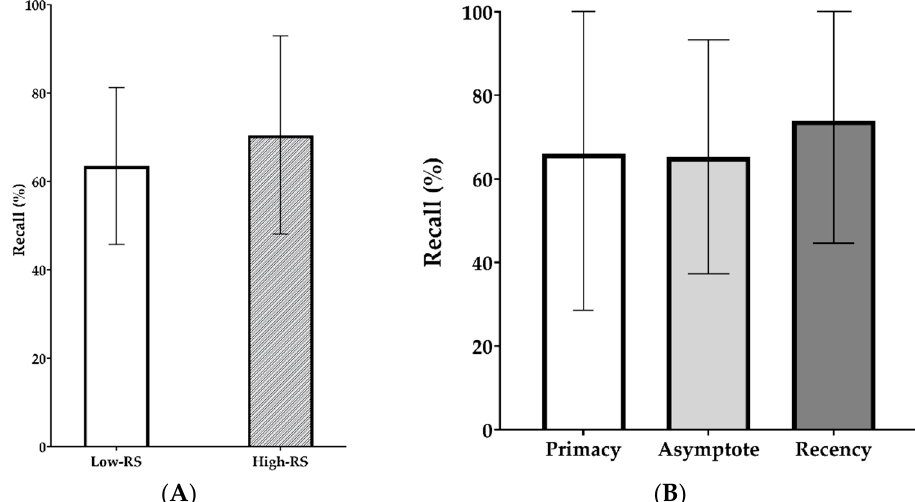
Figure 2. Results of Experiment 1. Mean recall percentages in the stationary noise condition ( A ) as a function of reading span (RS) group (low- and high-RS groups); ( B ) as a function of serial position (primacy, asymptote, and recency).